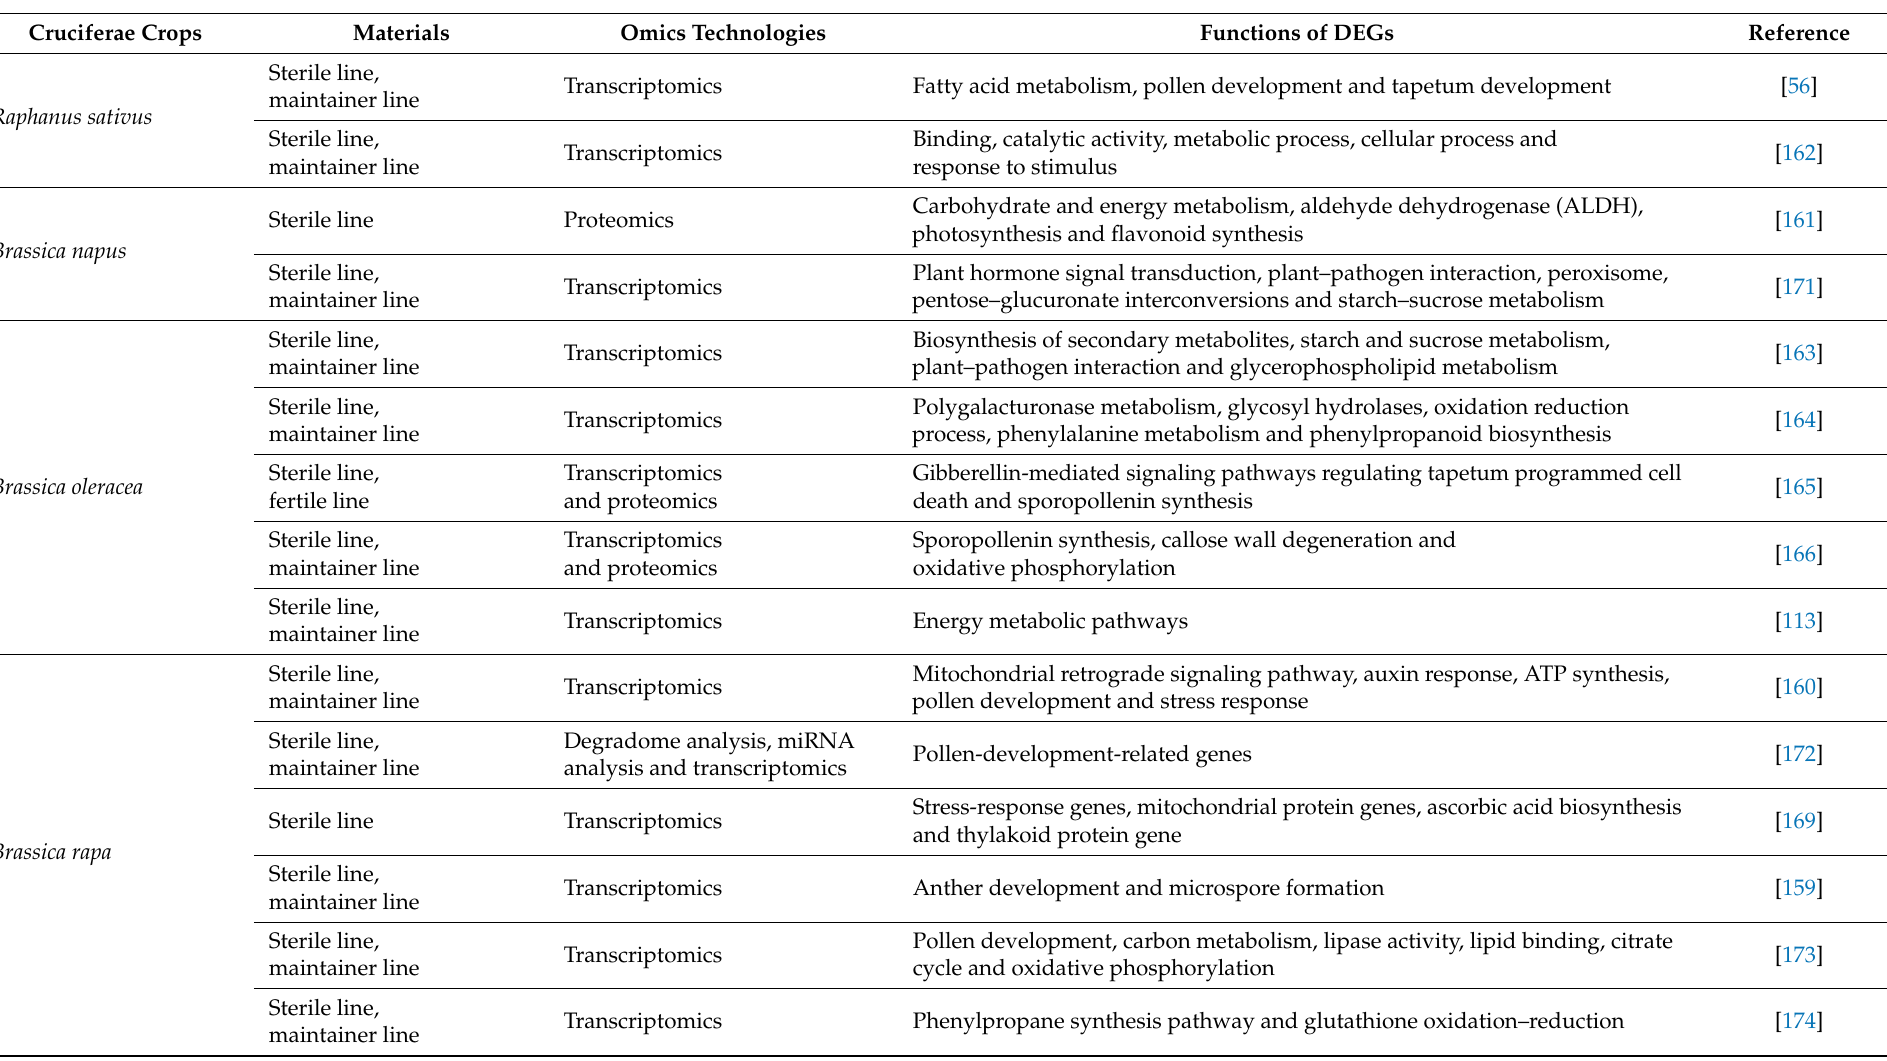
Table 3. Various -omics studies on Ogura CMS in cruciferous